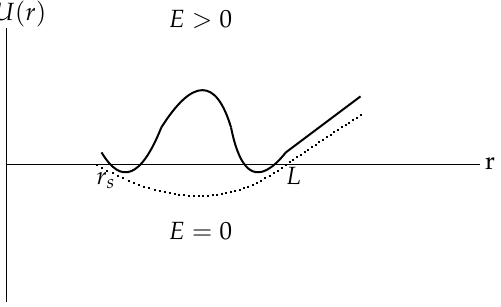
Figure 5. The effective potential U(r) for a tachyon outside of a black hole, with